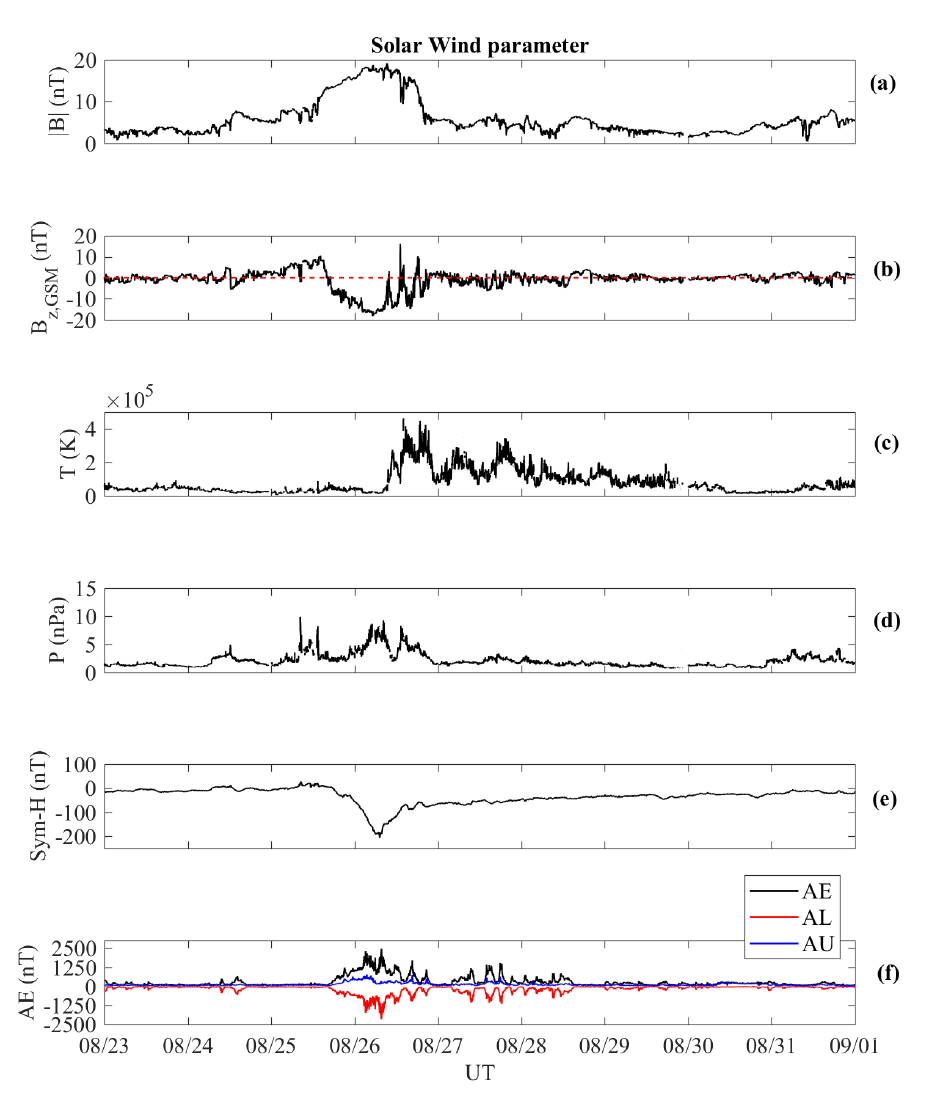
Figure 3. Solar wind parameters observed by the ACE spacecraft at L1: ( a ) IMF intensity; ( b ) IMF B z component; ( c ) proton temperature; ( d ) dynamic pressure of the solar wind; ( e ) Sym-H index; ( f ) AE (black), AL (red), and AU (blue) indices. The SW parameters are expressed in the Geocentric Solar Magnetospheric (GSM) coordinate